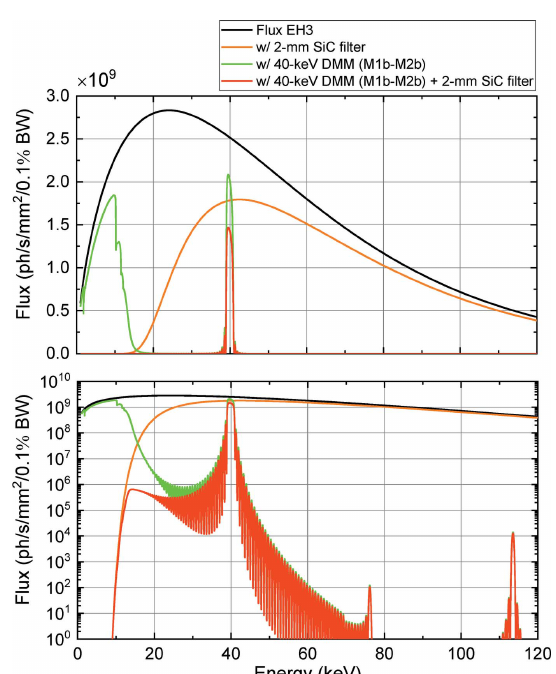
Figure 6 Calculated photon flux densities at EH3 under various conditions. The black line represents the photon flux density generated by the source. The green and orange lines represent the densities obtained using the 40 keV DMM (M1b–M2b) and 2 mm SiC filter, respectively. The red line represents the density obtained using both the 40 keV DMM and 2 mm SiC filter. The vertical axes of the graphs are drawn in linear (upper) and log (lower) scales.